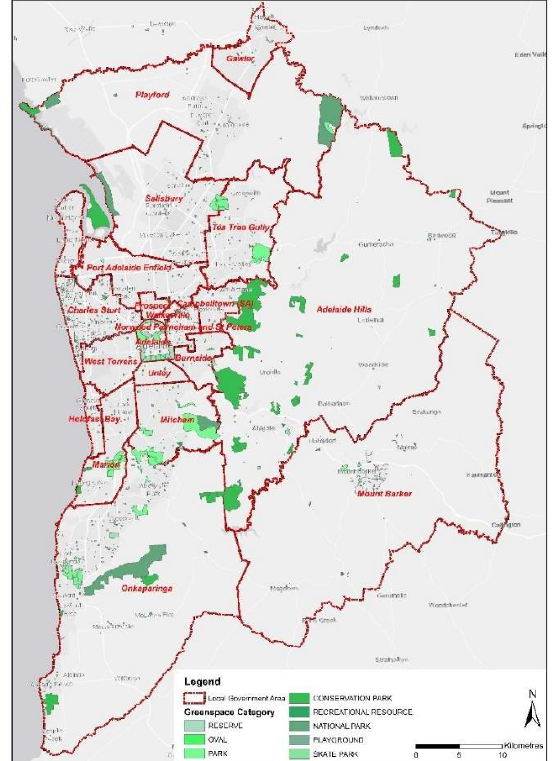
Figure 2. Public UGSs in Adelaide Metropolitan